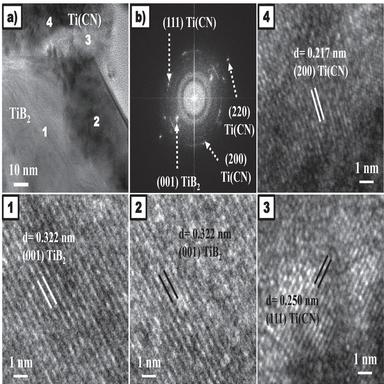
a) High-resolution TEM (HRTEM) image for 600TiBCN showing the presence of both Ti(CN) and TiB2 phases. b) Fast Fourier Transform (FFT) image obtained from the 600TiBCN HRTEM image. Numbers 1, 2, 3 and 4 (marked also in Fig. 5a) correspond to crystallographic planes detected for both the TiB2 and Ti(CN) phases.